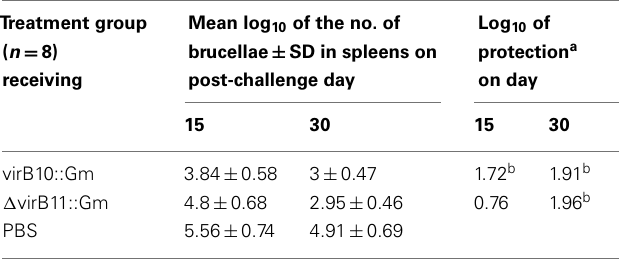
Table 1 | Protection against B. canis wild-type.